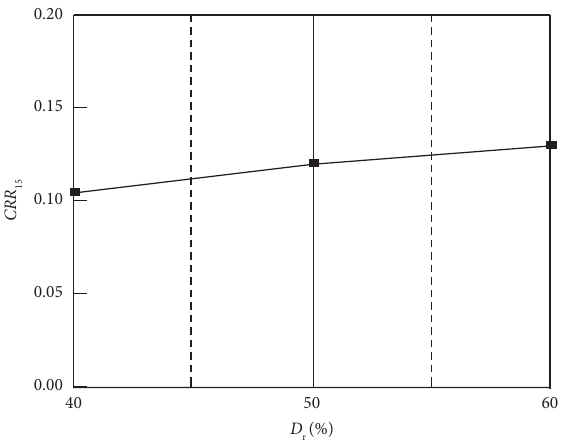
L of various mixtures for various D r